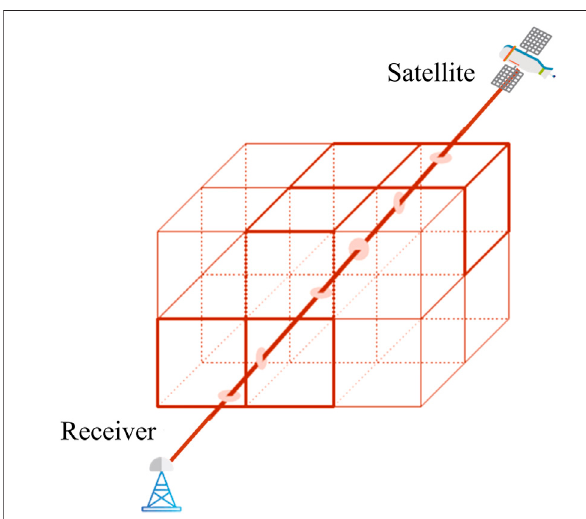
FIGURE 3 | Scheme of the ionosphere divided into voxels. The basic function ( δ ) equals 1 for the darker cubes (i.e., those “ illuminated ” by the ray) and 0 otherwise.